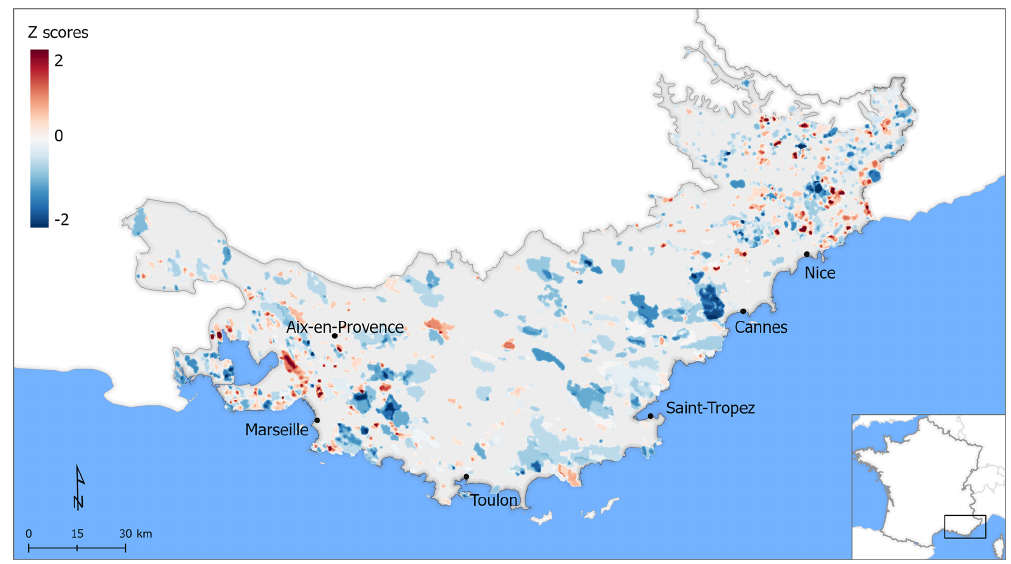
Figure 10. Trends of mean annual burned area between 1970 and 2019, based on the contextual Mann–Kendall method. Areas with positive Z scores depict increasing trends in the burned area, while negative Z scores show decreasing trends.